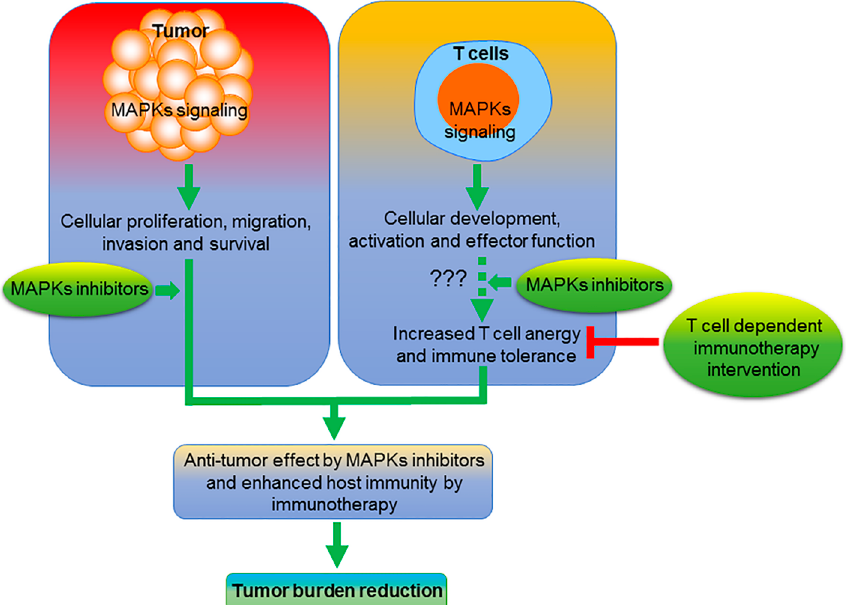
Figure 1. Schema describing the potential interaction between MAPK inhibitors and cancer immunotherapy. In the proposed model, we suggest that MAPK inhibition may function through two distinct mechanisms. While blockade of various MAPKs limits the proliferation of tumor cells and promotes apoptosis, they may also precipitate T-cell exhaustion and/or anergy, which may potentially be reversed through the use of selective immunotherapies.